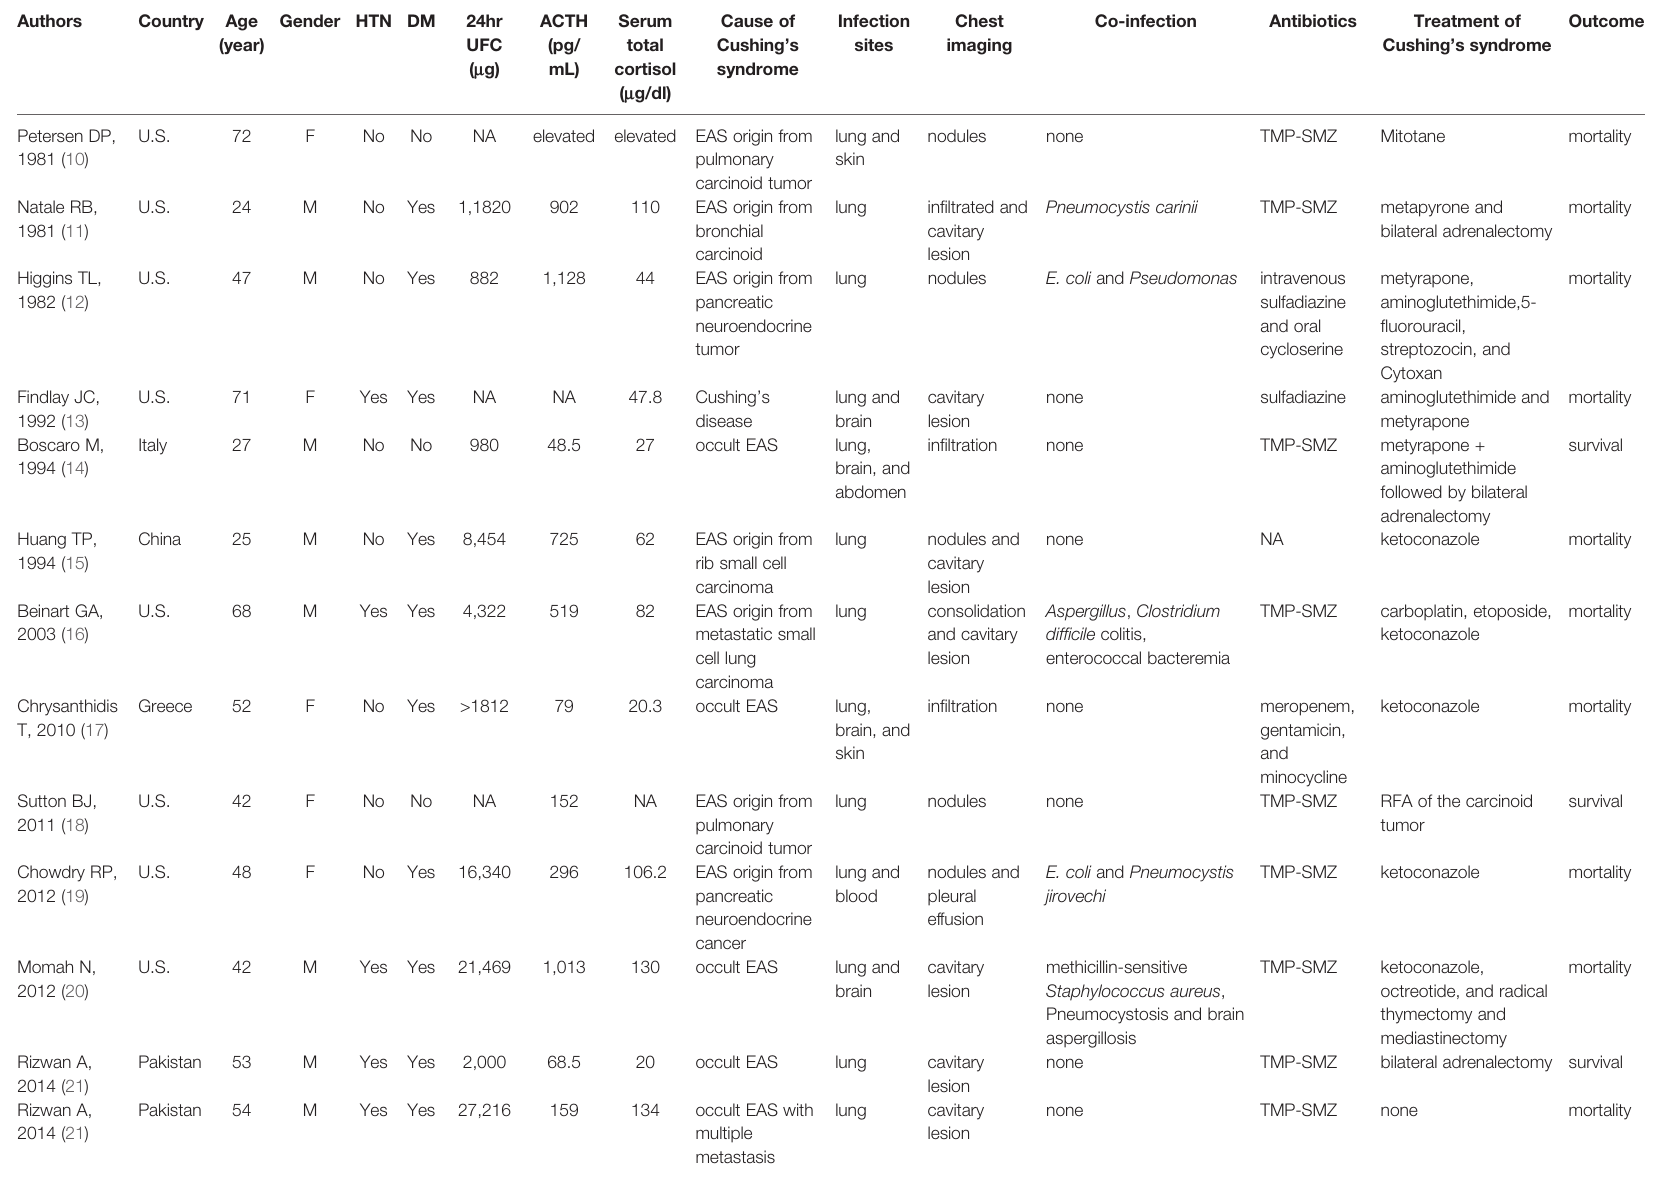
TABLE 1 | Clinical characteristics, diagnosis, treatments, and outcomes of 18 patients of Cushing ’ s syndrome with nocardiosis. Authors